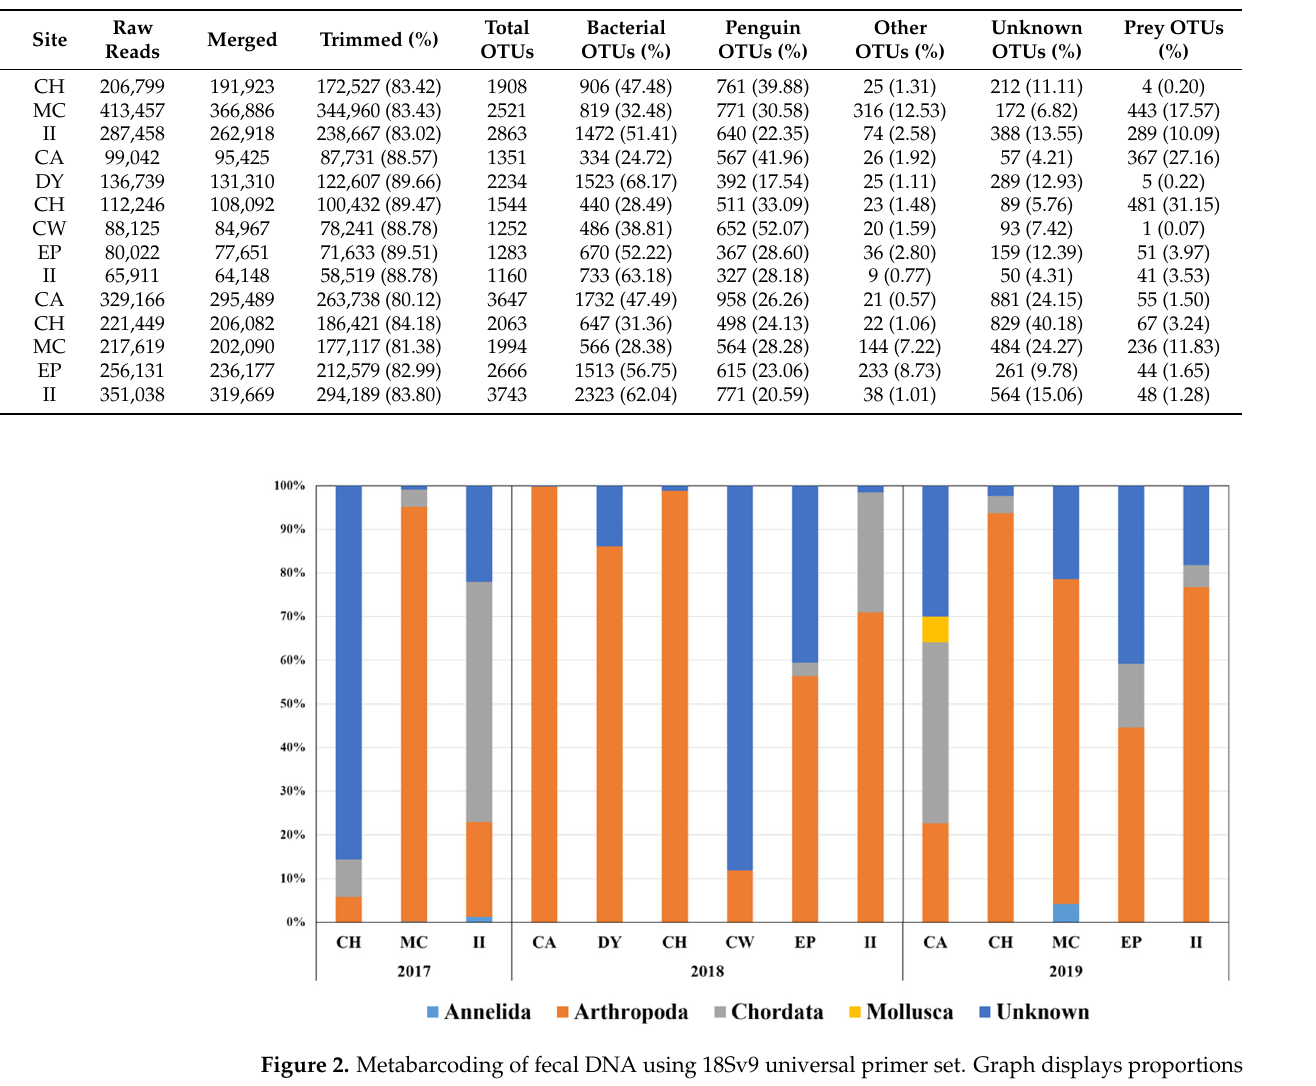
Table 3. Reads of fecal DNAs generated using 18Sv9 universal primer set.